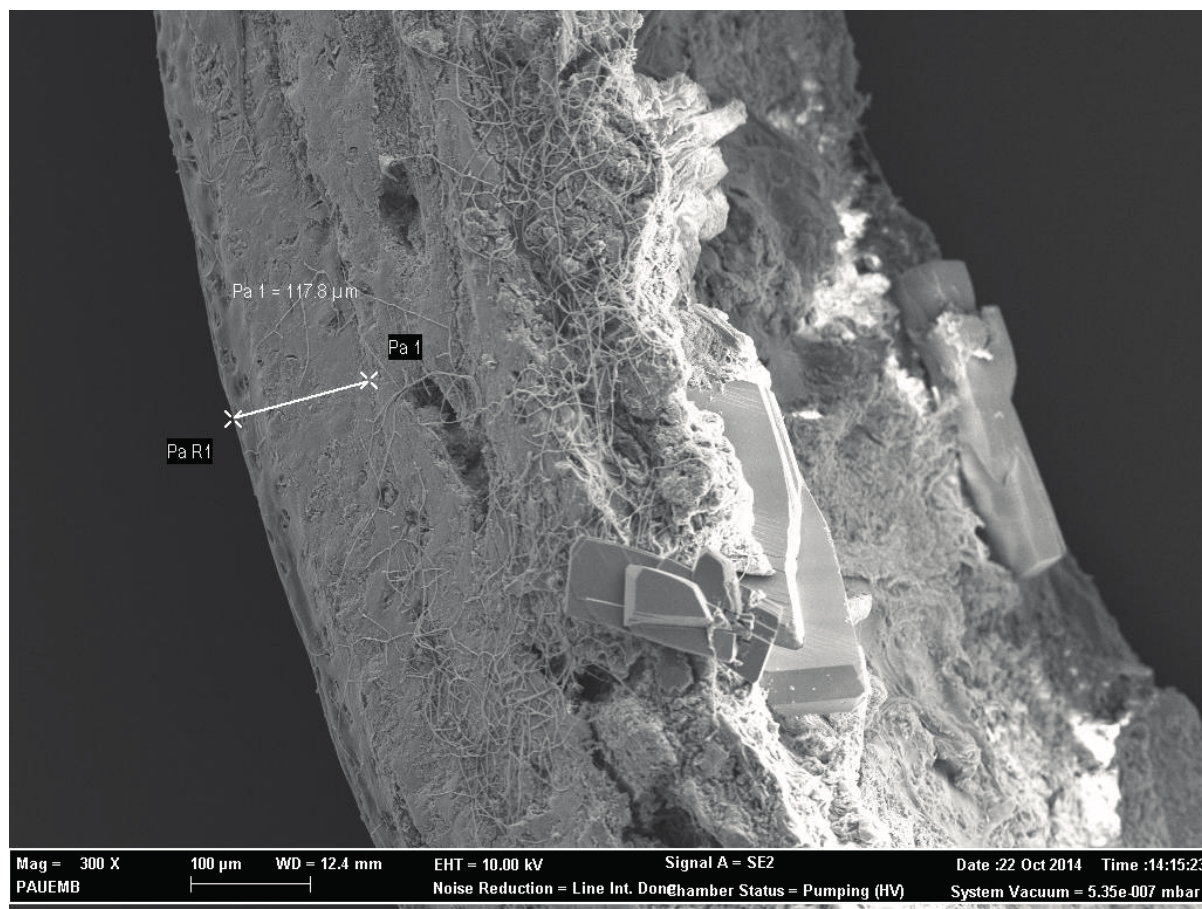
Figure 1. Measurement of cortical bone thickness (at 300× magnification) on the FESEM image (specimen from Group